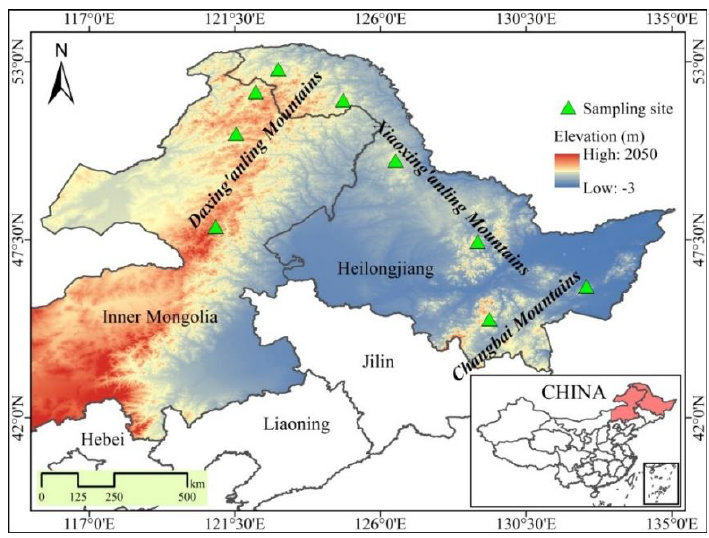
Figure 1. The location of the study area and sampling sites in northeastern China.